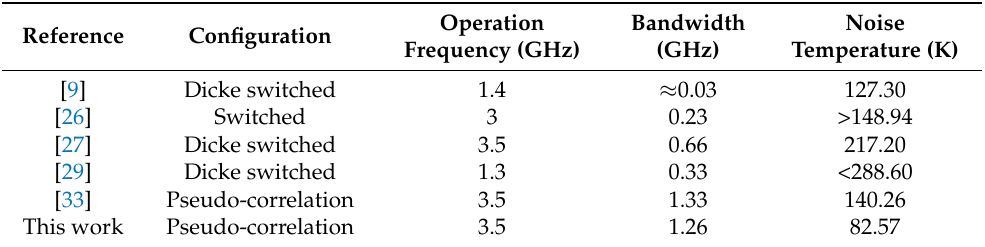
Table 1. Comparison between the proposed radiometer and other MWR systems for biomedical